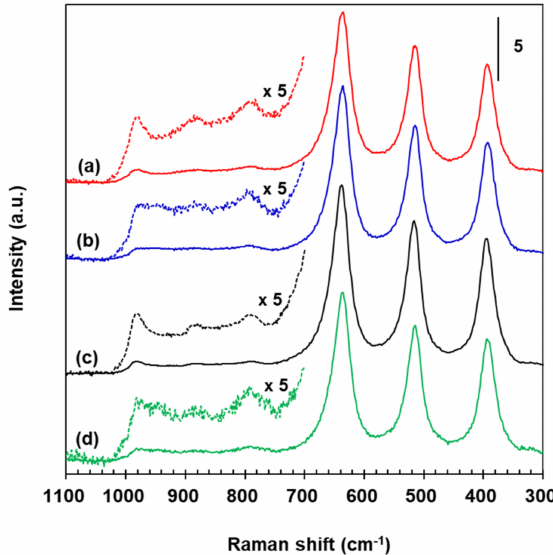
Figure 8. Raman spectra for unpromoted and promoted V 2 O 5 /TiO 2 -based catalysts: ( a ) VWT; ( b ) 2.73% Fe 2 O 3 /VWT; ( c ) c-VWT; ( d ) 2.73% Fe 2 O 3